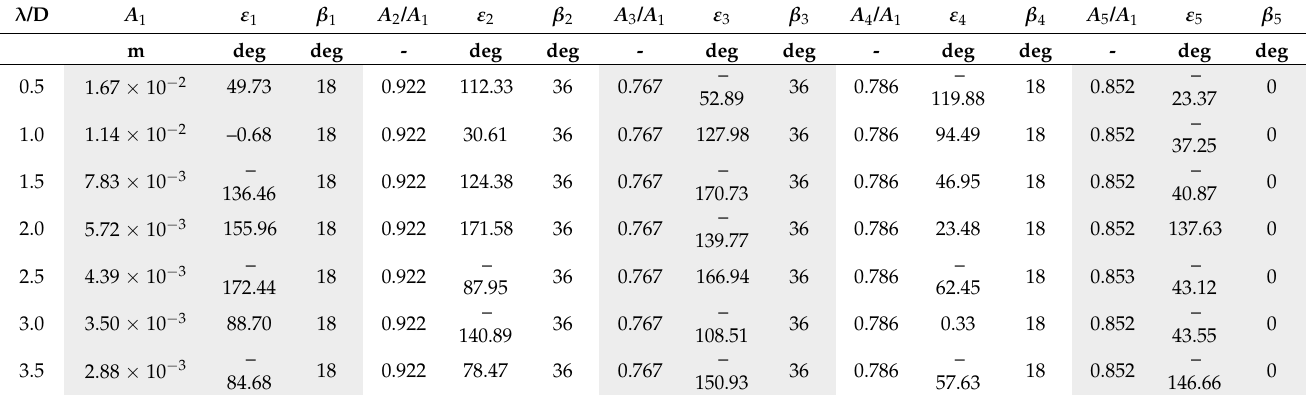
Table 1. Undisturbed incoming wave conditions for oscillating body W 1 at each